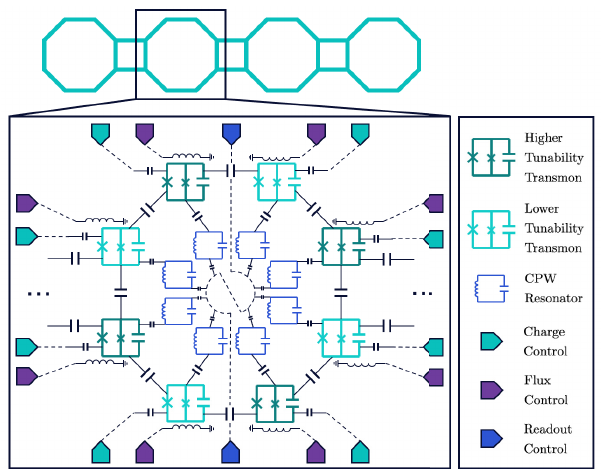
FIG. 2. A circuit diagram representation of the devices used in this study. The full lattices include either 32 or 40 tunable transmons, with the topology of eight presented here constitut- ing an octagonal unit cell that is repeated four or five times to make up a full device. Dispersive readout is achieved via copla- nar waveguide (CPW) resonators capacitively coupled to each transmon, and readout signal delivery is multiplexed eightfold by the octagon. These transmons are tunable via inductively cou- pled flux lines and excitable via capacitively coupled rf drive lines. There is a static capacitive coupling between each pair of neighboring qubits. The lattice alternates between two classes of transmon that differ in frequency band and tunability. Para- metric gates are performed by modulating the higher frequency, higher tunability qubits and placing negative-indexed sidebands on resonance with the capacitively coupled, lower-frequency neighbors.